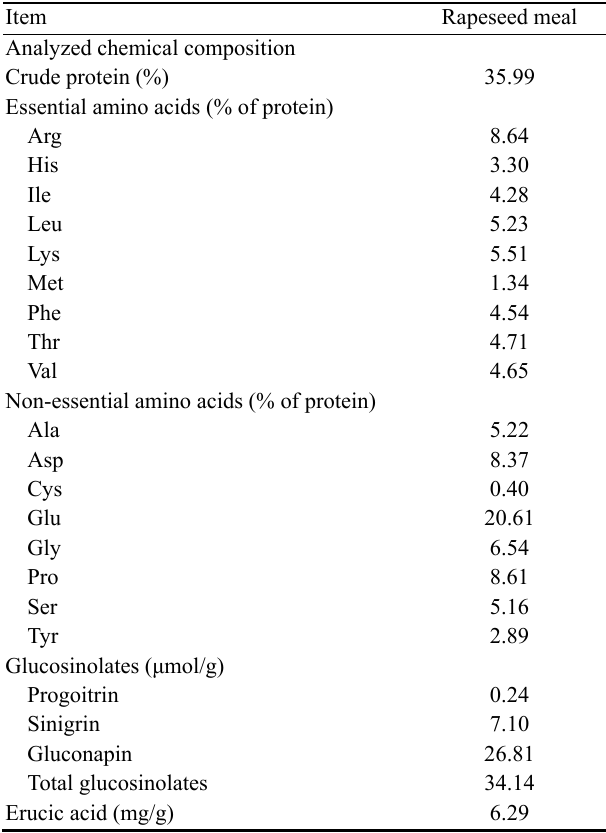
Table 1. Anti-nutritional factors contents and